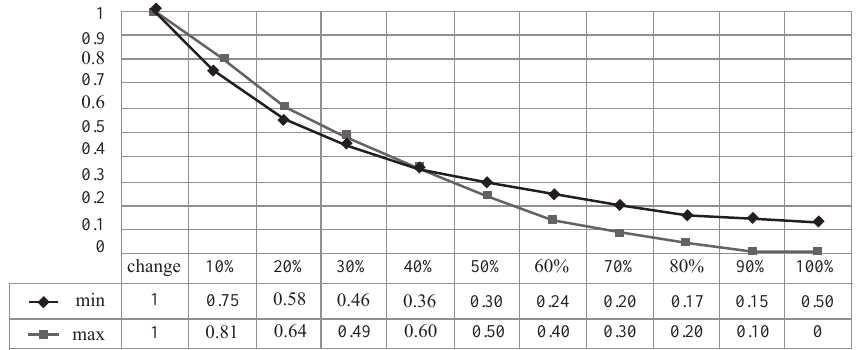
Fig. 2. Reduction of the unintentional weighting according to formula